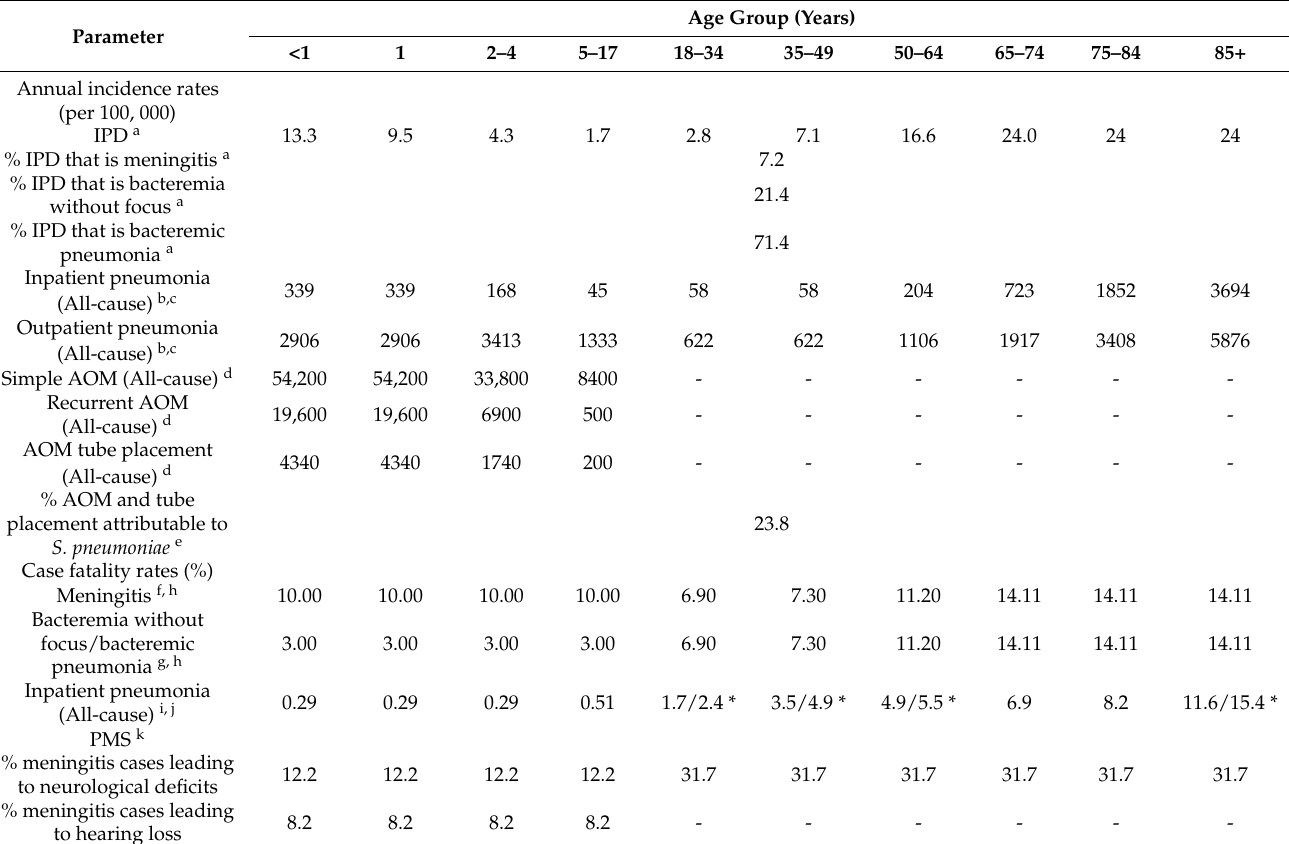
Table 1. Pneumococcal disease incidence and case fatality rates by